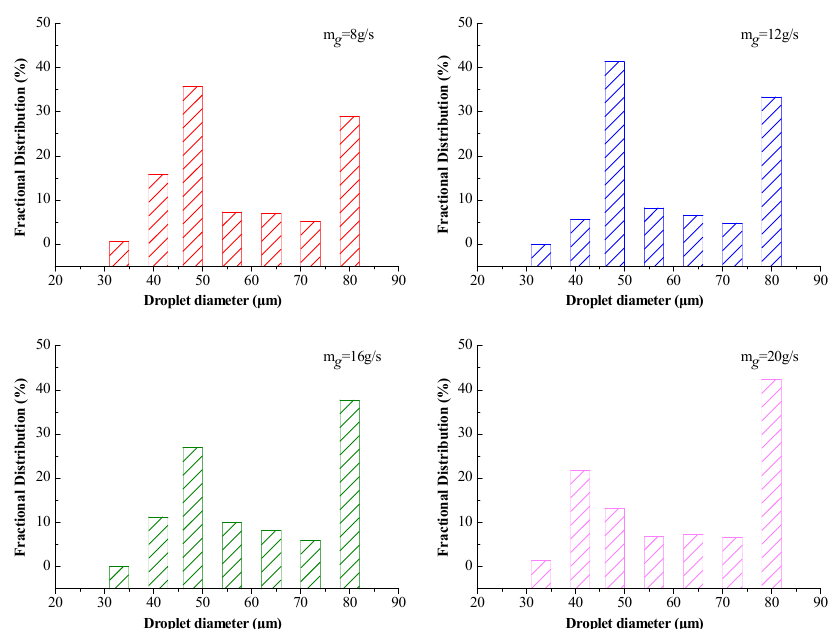
Figure 10. The influence of air inflow on the oil droplet size distribution when the oil inflow is 15 g/s, the initial oil droplet diameter is 28 μm at t = 250 ms.